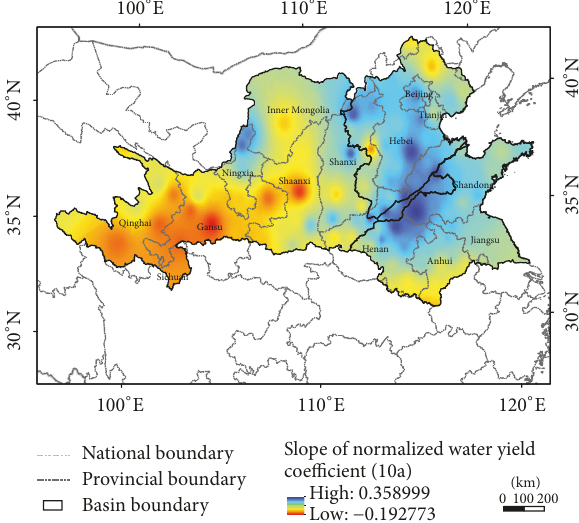
Figure 11: Rate of change in the normalized WYC from 1982 to 2011. 51.15 mm/10a, 25.46 mm/10a, and 6.43 mm/10a, respectively; and the trends for rainstorm days are 0.38 d/10a, 0.18 d/10a, and 0.05 d/10a, respectively. In Figure 13(c), the three points are located in the second quadrant, with abscissa values of − 1.26 d/10a, − 0.94 d/10a, and − 0.47 d/10a, respectively, indicating decreases in the absolute values. In Figure 13(d), the abscissa values of the three points are 0.014/10a, 0.021/10a, and 0.020/10a, broadly indicating that as the WYC trend becomes smaller the NDVI trend becomes larger. In the first type, arable land accounted for the largest proportion in the region, close to 70%, but the area did not change much during the study period. Grassland decreased from 11,172 km 2 to 8,269 km 2 , representing a decrease of 25.98%. The area